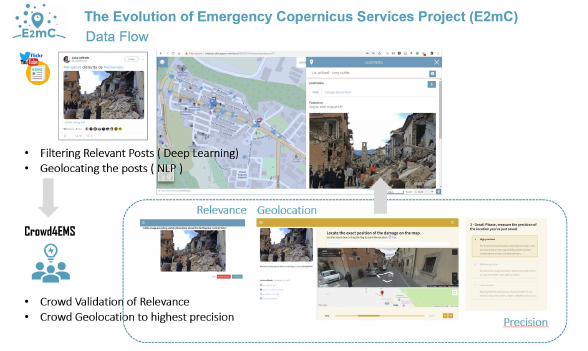
Figure 2. Data Flow in